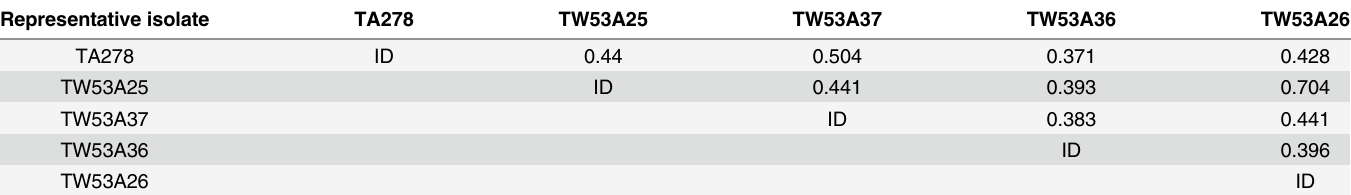
set 2 (TW53A26 as a representative isolate) were clustered together into a discrete monophy- letic clade (the “ group 6 ” ) The TW53A37 was clustered together with recently identified Hebei-1 strain (the “ group 7 ” ). Both clades were distinct related to all other previously known strains with posterior probabilities of 1.0 (Fig 1). Table 2. Pairwise similarity table for ORF1 amino acid sequences by comparing representative strains to TTV prototype TA278. Representative